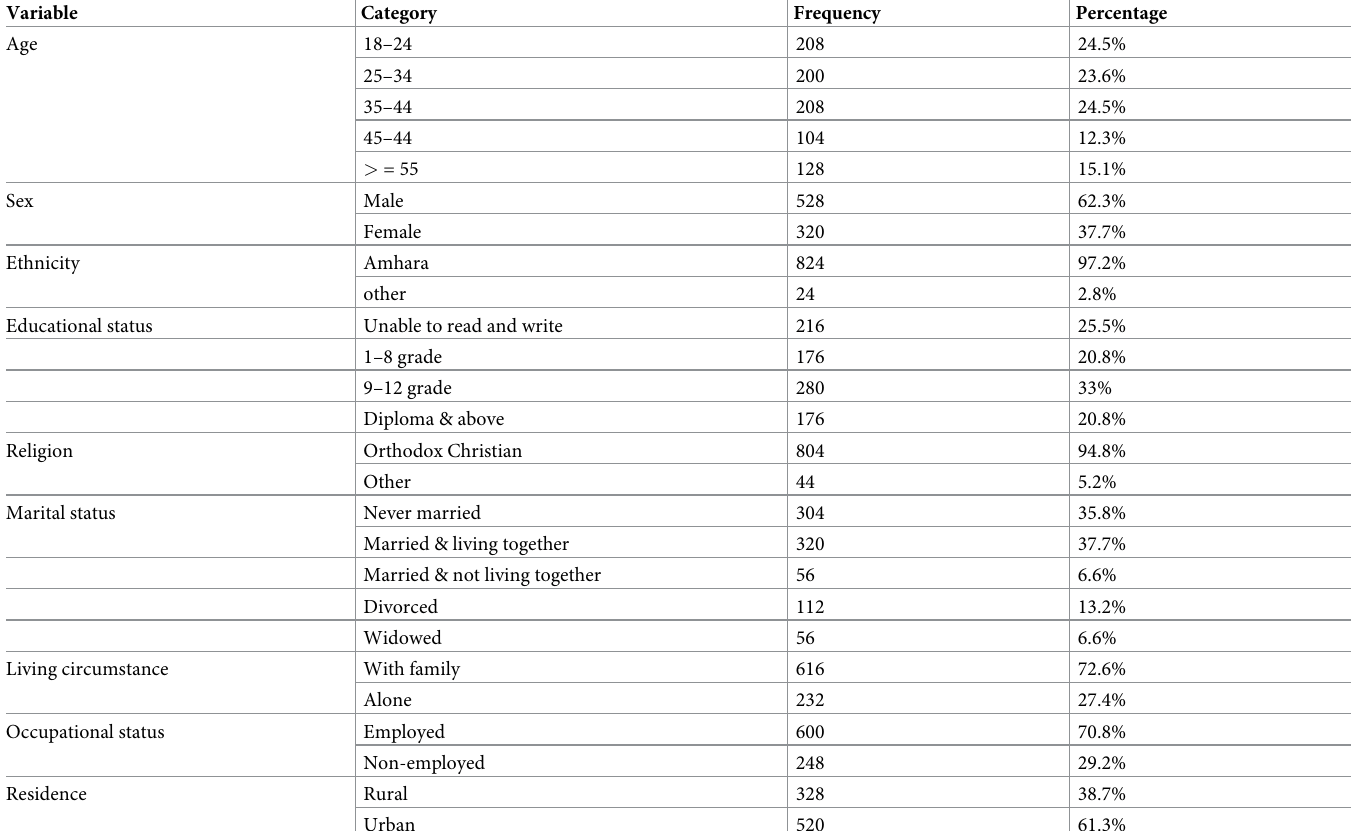
Table 1. Socio-demographic characteristics of the participants in south Gondar zone, northwest Ethiopia, 2020 (n = 848). Variable Category